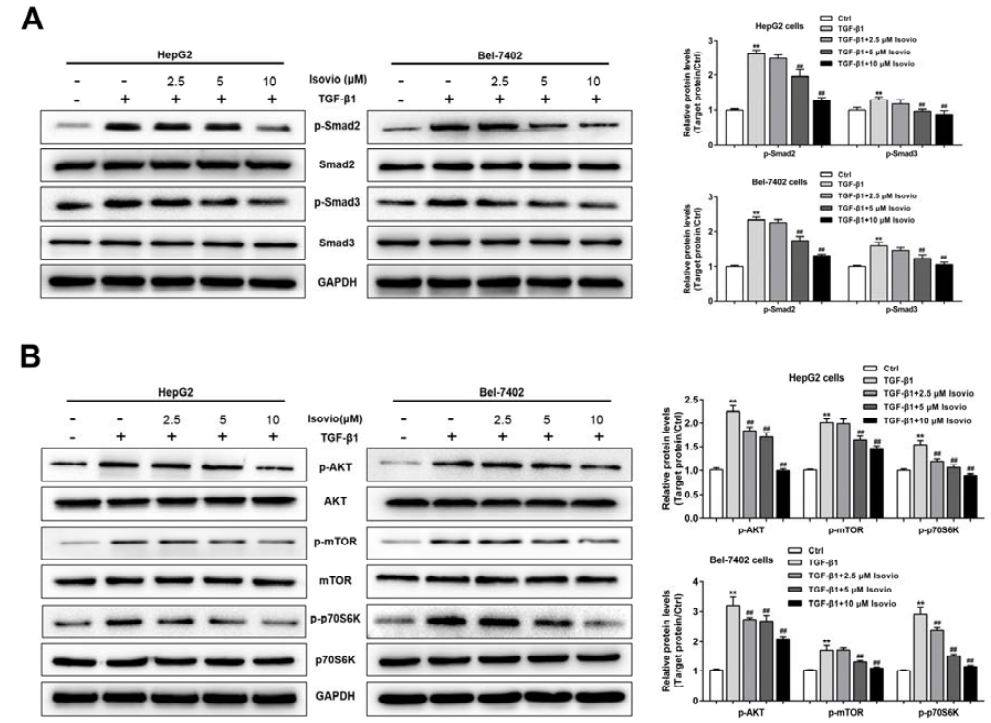
Figure 6. Effects of isoviolanthin on the TGF- β /Smad and PI3K/Akt/mTOR pathways in HCC cells. ( A ) HepG2 and Bel-7402 cells were treated with 10 ng/mL TGF- β 1 for 48 h, during which the indicated concentrations of isoviolanthin were added for the last 24 h. The expression of TGF- β /Smad pathway-related proteins, such as Smad2, p-Smad2, Smad3, and p-Smad3, was examined by Western blot analysis; ( B ) The expression of PI3K/Akt/mTOR-pathway-related proteins, including Akt, p-Akt, mTOR, p-mTOR, P70S6K, and p-P70S6K, was examined by Western blot analysis. GAPDH was used as a loading control. Representative images and bar graphs (mean ± SD) are shown, n = 3. ** p < 0.01 versus the control group; ## p < 0.01 versus the TGF- β 1